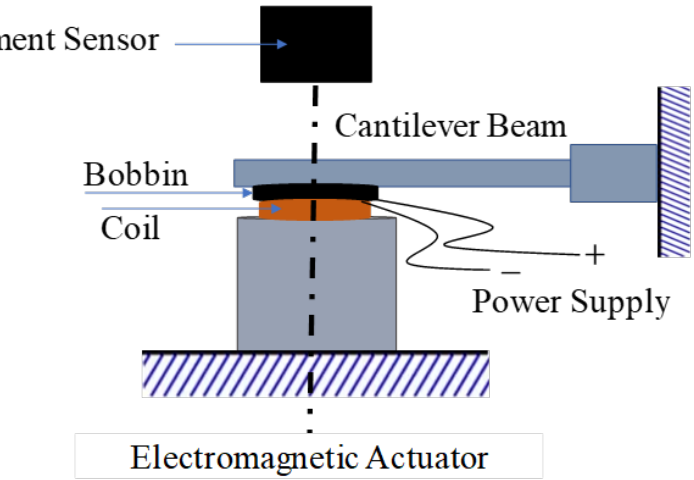
Figure 4. Setup to check electromagnetic damping for voice-coil actuator (VCA).